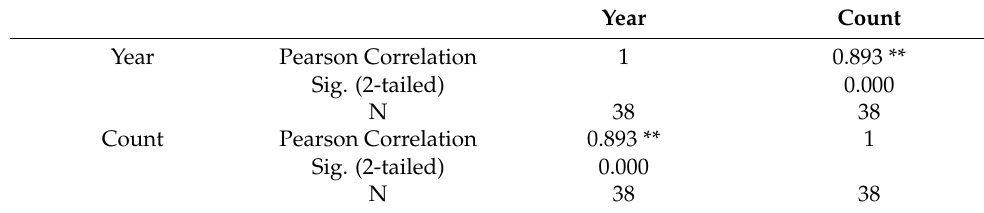
Figure 2. Publication counts and cumulative counts over years. Table 4. Statistical analysis of counts and years.